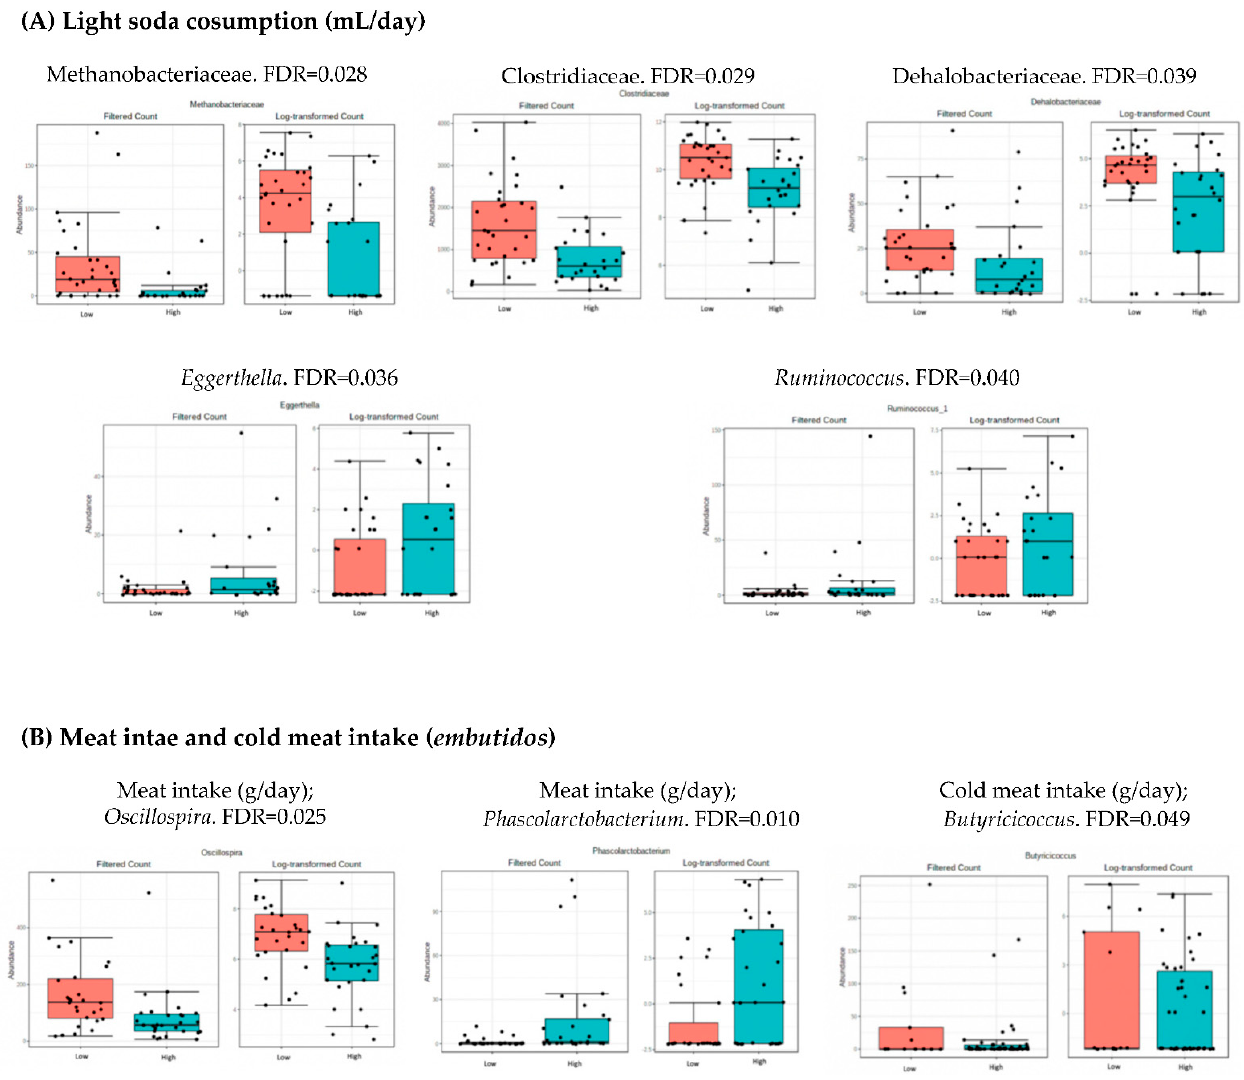
Figure 4. Bacterial taxa differing significantly in relation to the consumption of light soda ( A ) and meat and cold meat intake (embutidos) ( B ) (FDR < 0.05). Red boxes represent participants with lower consumption, and blue boxes represent participants with higher consumption of the specified food group compared to the median.